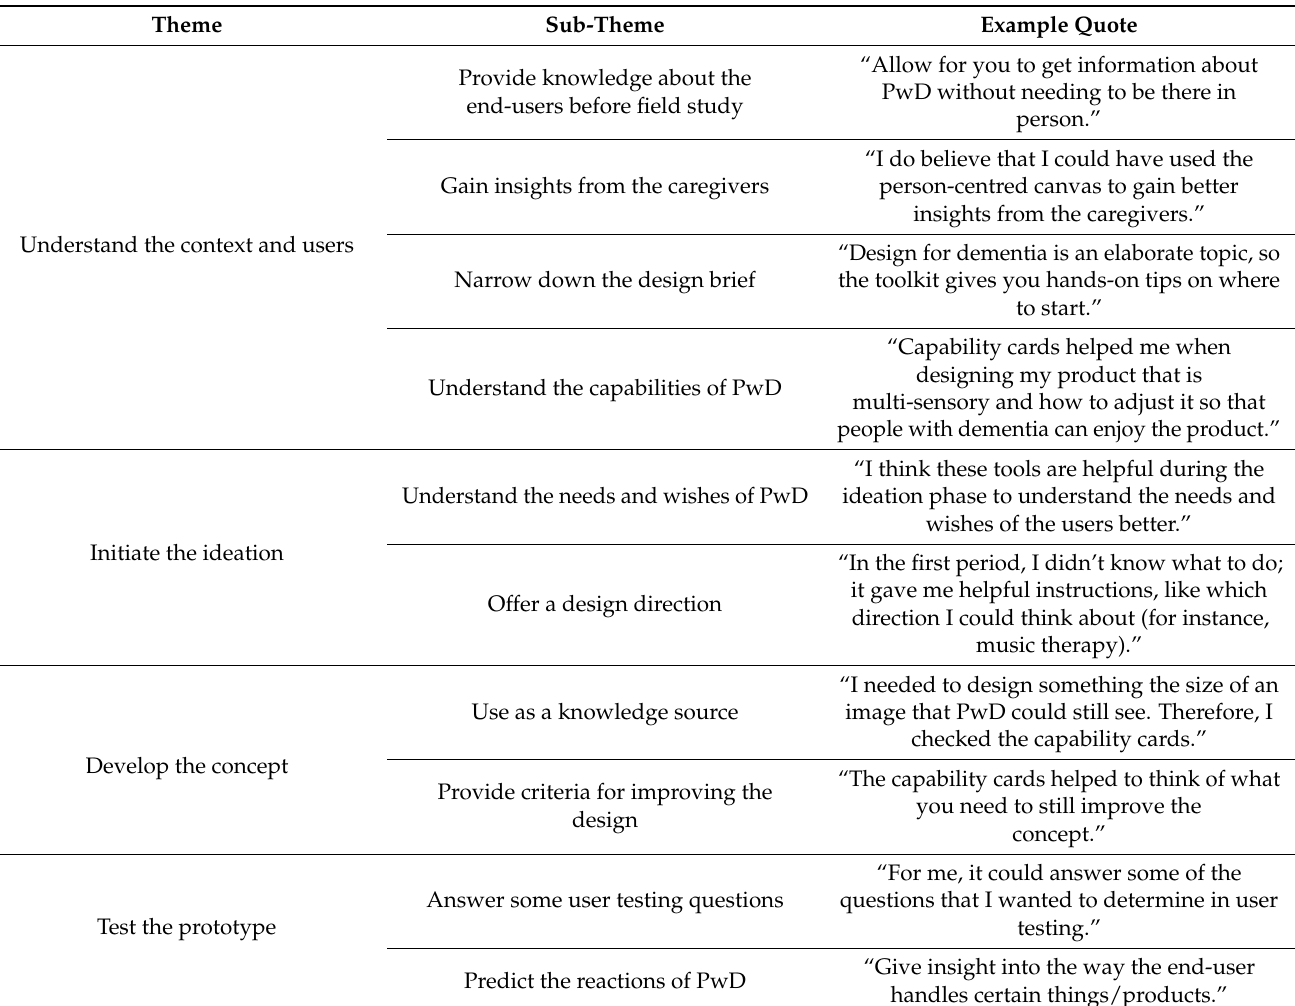
Table 1. Themes and sub-themes on how the “Know-me” toolkit is perceived to contribute to the design process with example